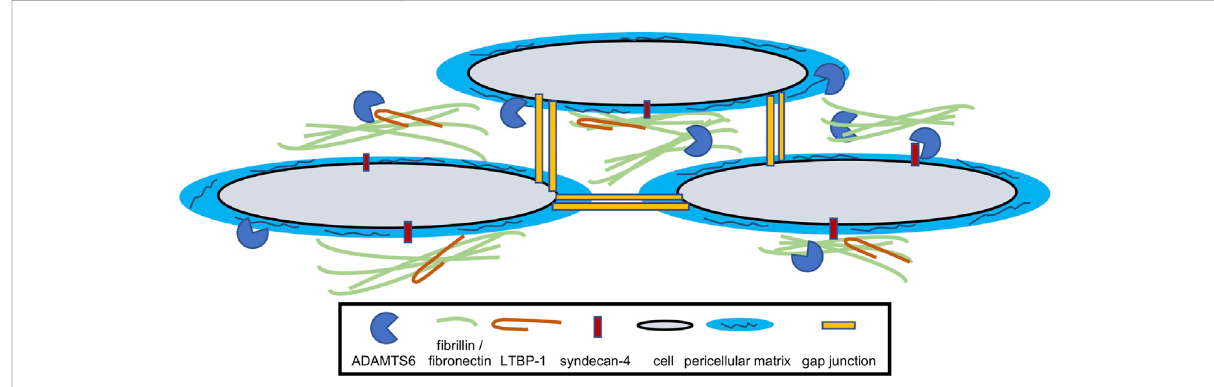
Model for the function of ADAMTS6. ADAMTS6 locates and functions within the extracellular matrix and has been shown to cleave fi brillin-1, fi brillin-2, fi bronectin, LTBP-1 and syndecan-4. It directly or indirectly effects cellular gap junctions as well as pericellular matrix/glycocalyx